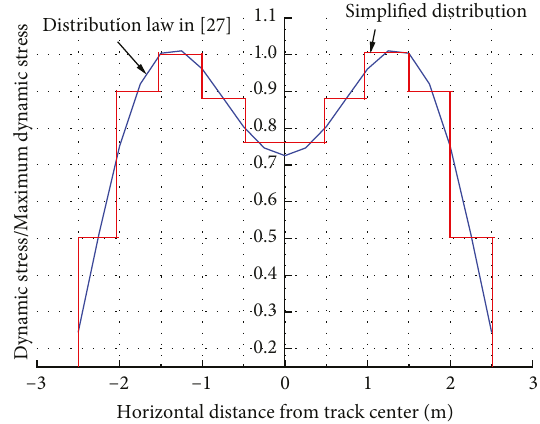
Figure 13: Distribution of the input loads along the cross section of the embankment.